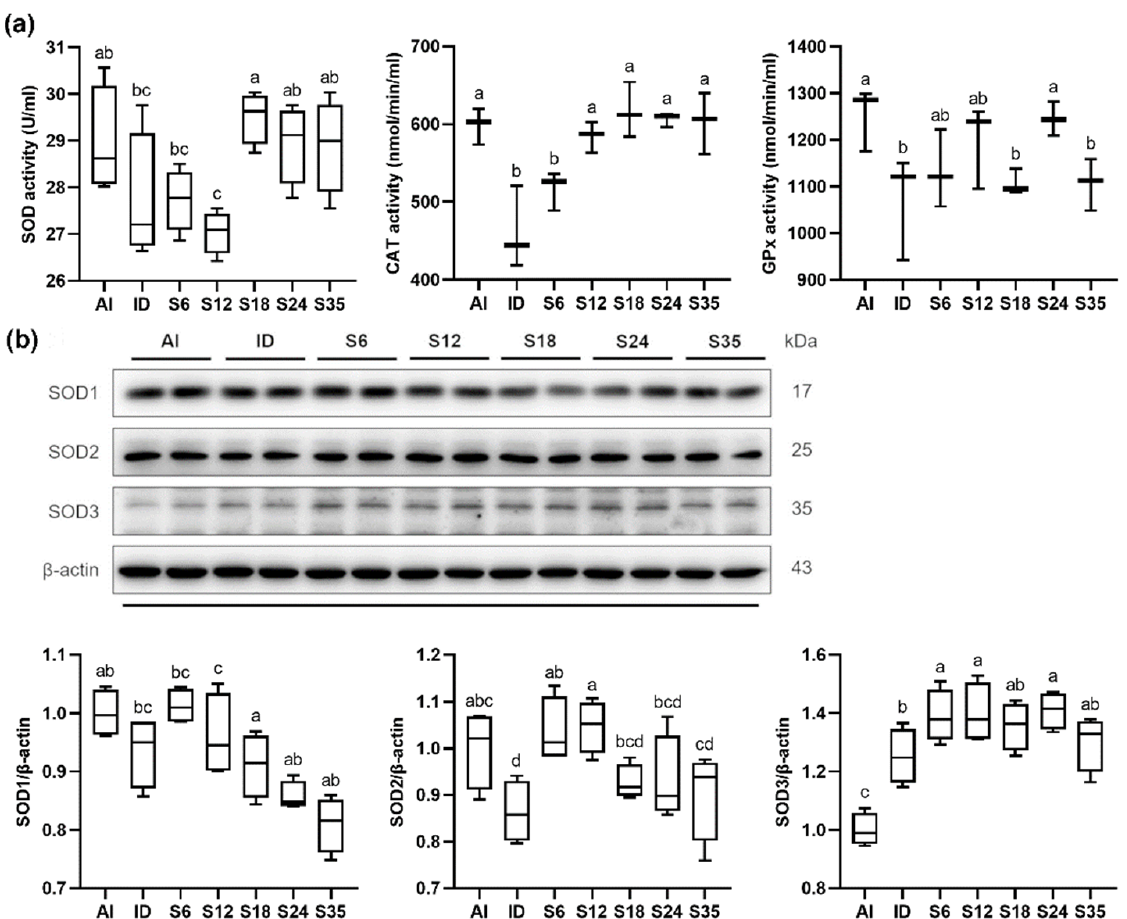
Figure 9. Effects of different doses of iron supplementation on ( a ) testicular antioxidants and ( b ) protein expression of SOD in iron-deficient rats. Values are presented as median (interquartile range, IQR). n = 4 per group. Values not sharing the same letters are significantly different at p < 0.05. As SOD is a metal-dependent enzyme, the protein expressions of different forms of SOD in the testis were measured using western blot. Iron deficiency resulted in a lower protein expression of SOD2 (Mn-SOD) and higher SOD3 (extracellular Cu/Zn-SOD), whereas a decreasing trend in SOD1 (intracellular Cu/Zn-SOD) was observed. The protein expressions of SOD1 and SOD2 showed a similar trend, increasing in the 6 and 12 ppm iron supplementation groups and decreasing in the 18, 24, and 35 ppm